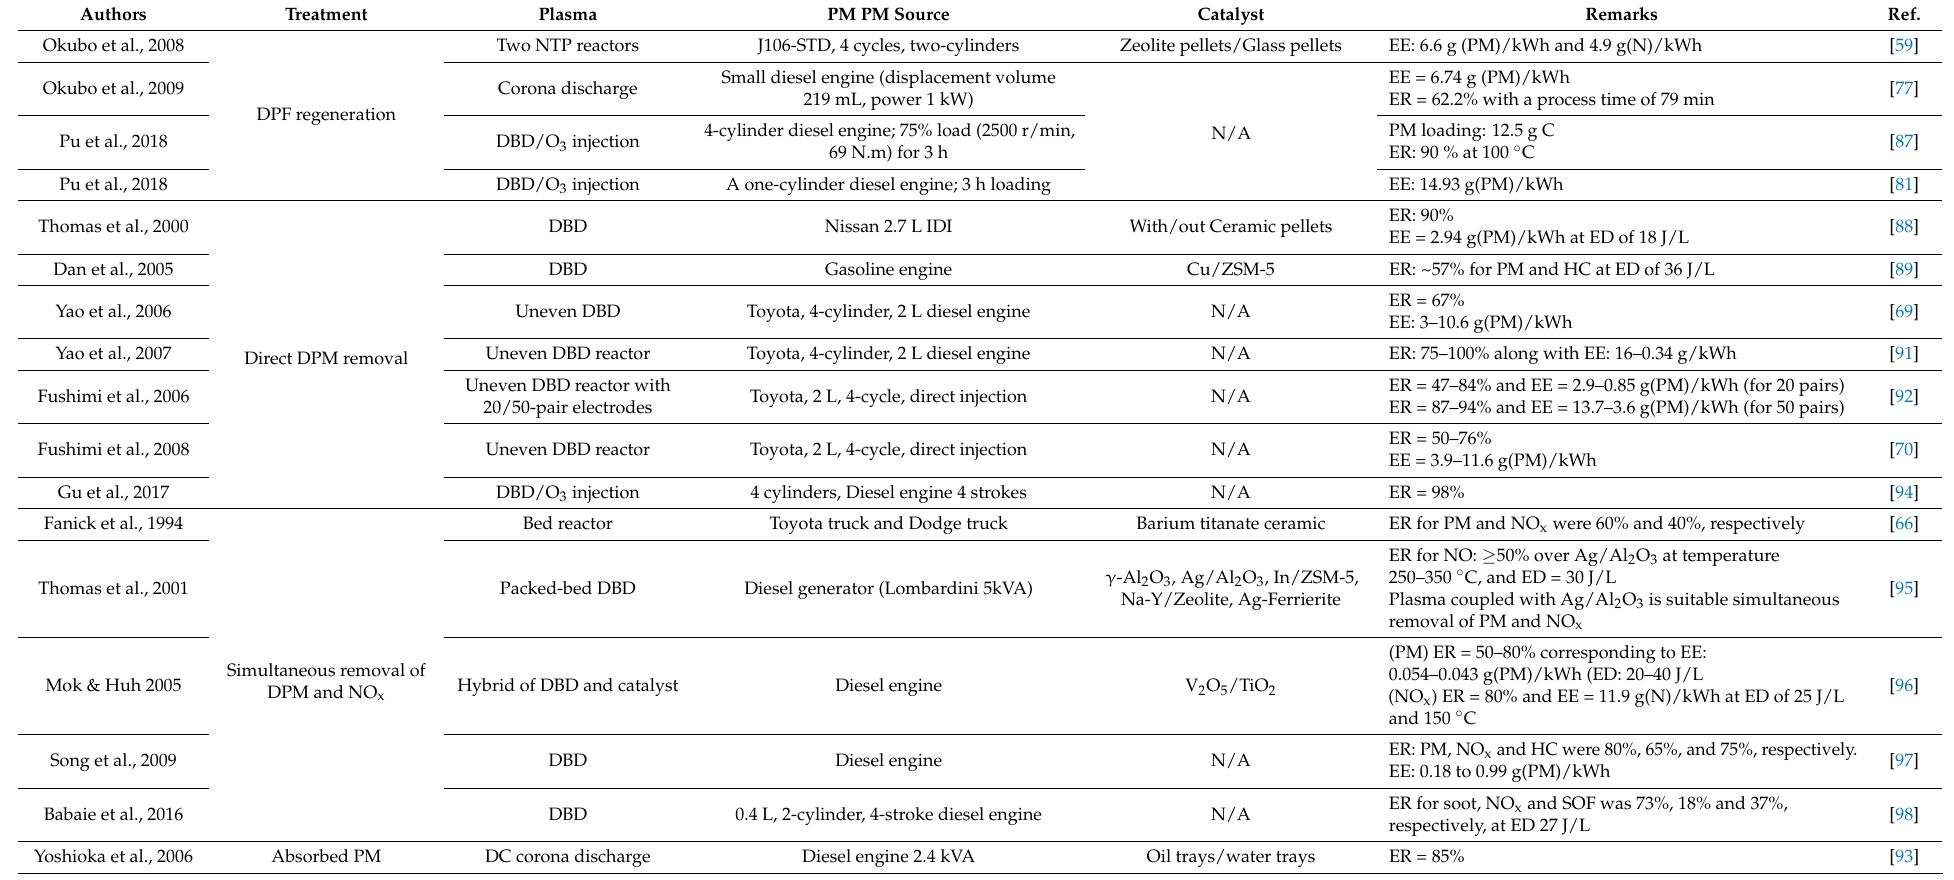
Table A2. A comprehensive review of published papers featuring non-thermal plasma for DPM treatment from diesel